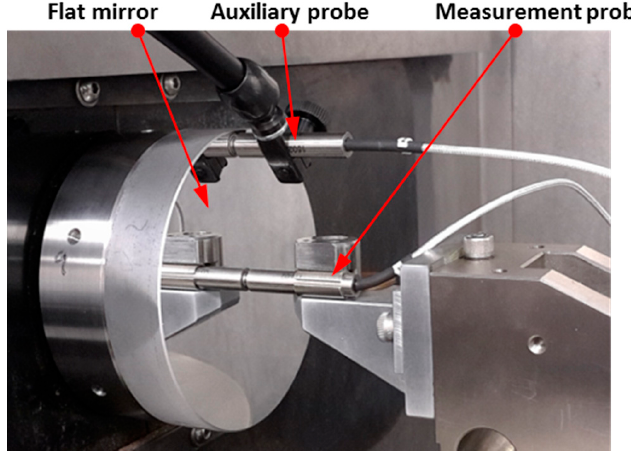
Figure 12. Schematic diagram of E BOC measurement. ( a ) Before reversal operation, ( b ) After reversal operation.